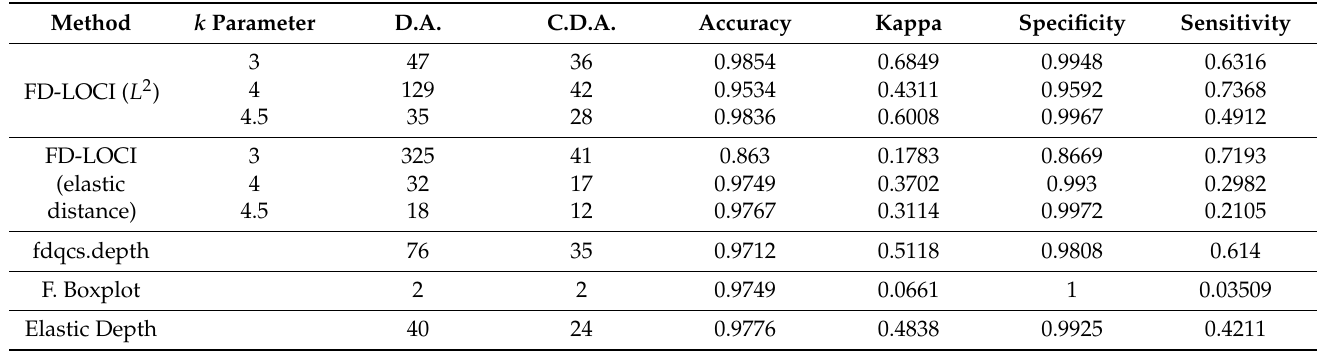
Table 9. Performance measures of the methods used to detect anomalies (57 actual anomalies detected by a group of experts). The proportion of correct classification (accuracy), the kappa index, the specificity, the sensibility, and the number of true alarms detected are included.